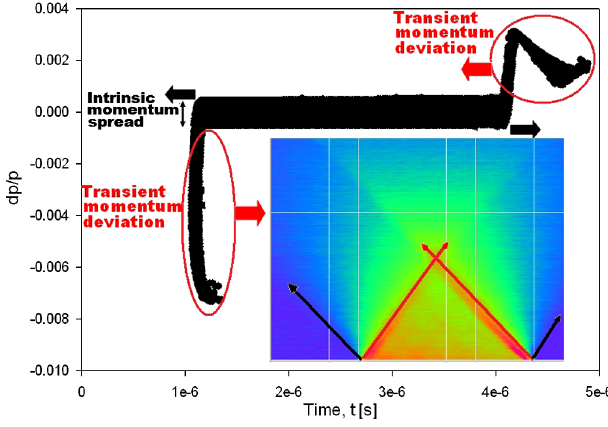
FIG. 39. Example of a mountain view with its momentum